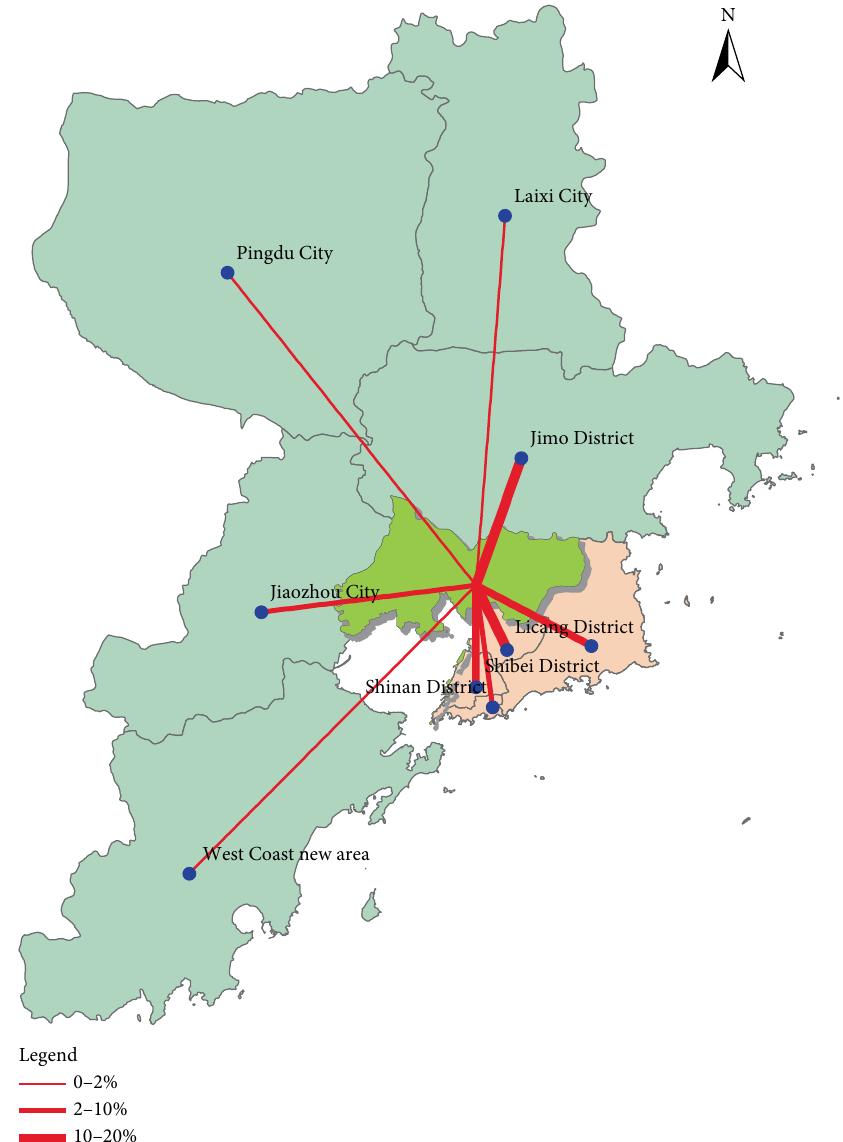
Figure 5: The internal–external linkage of north